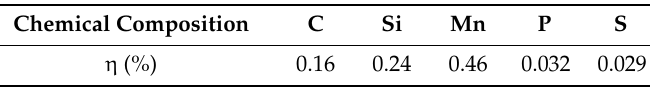
Table 1. Composition of steel